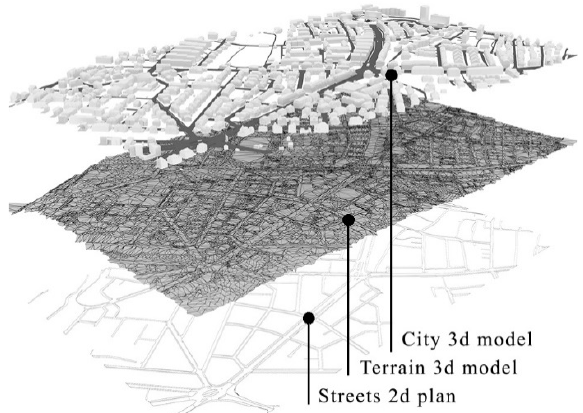
Figure 4. to obtain the 3D model we combined mainly three data collections: city 3D model (only buildings), terrain model, and streets 2d plans of two variants (existing and proposed